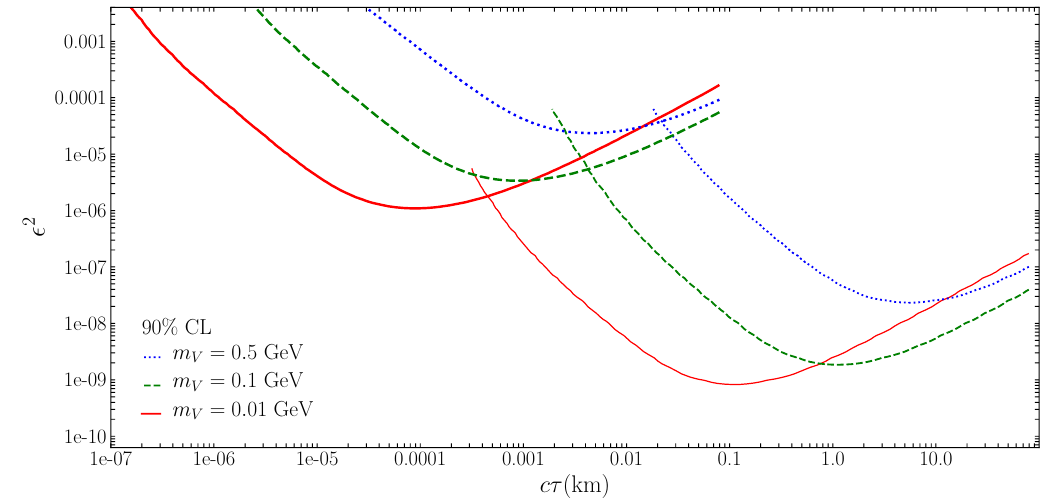
Figure 16 . Limits on dark photons decays from IceCube (thick lines) and Super-Kamiokande (thin lines) on the (cid:15) 2 vs c(cid:28) V plane including production from (cid:25) 0 ; (cid:17) decay and bremsstrahlung for m V = 0 : 01 GeV (solid), 0 : 1 GeV (dashed) and 0 : 5 GeV (dotted).